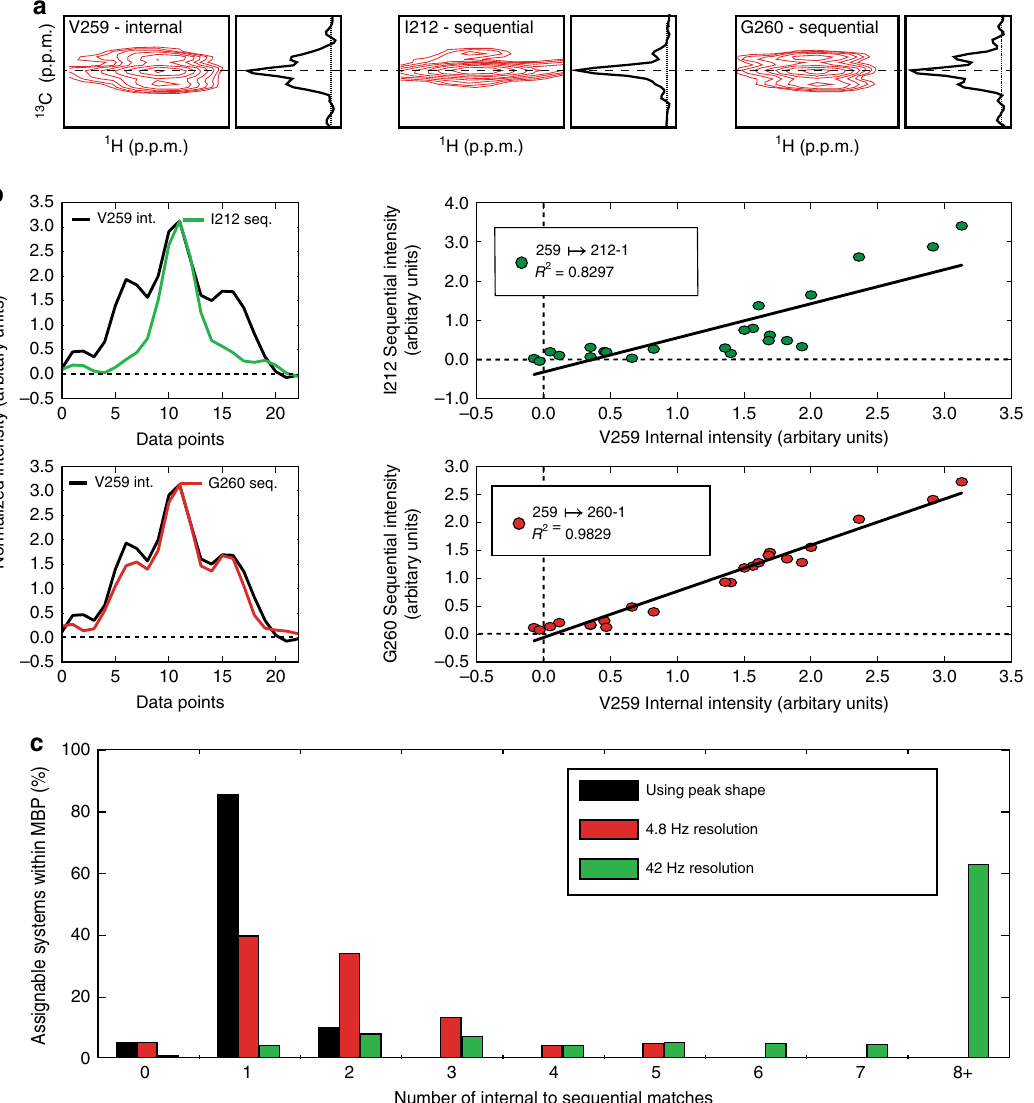
Fig. 4 Solving the chemical shift degeneracy problem in the HNCA for the 371 amino acid protein, MBP. a An internal C α peak (V259, right) and two candidate sequential peaks that match identically in chemical shift; I212 sequential (middle) and G260 sequential (left). b Overlay of the incorrect match (top left panel) and the correct match (bottom left panel). These matches are plotted as correlations (right panels) and scored with a correlation coef fi cient (inset). c Assignability of MBP based on chemical shift and peak shape. Completeness of assignment using a window of 42 Hz (typical HNCA, green), 4.8 Hz (high-resolution HNCA, red) and incorporation of peak matching correlations (black). Zero matches indicate that systems are adjacent to prolines